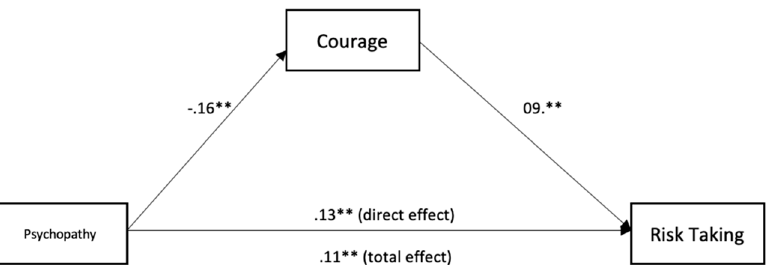
Figure 4. Mediation analysis for the relationship between psychopathy, honesty, and risk-taking. * p < 0.05; ** p < 0.01.